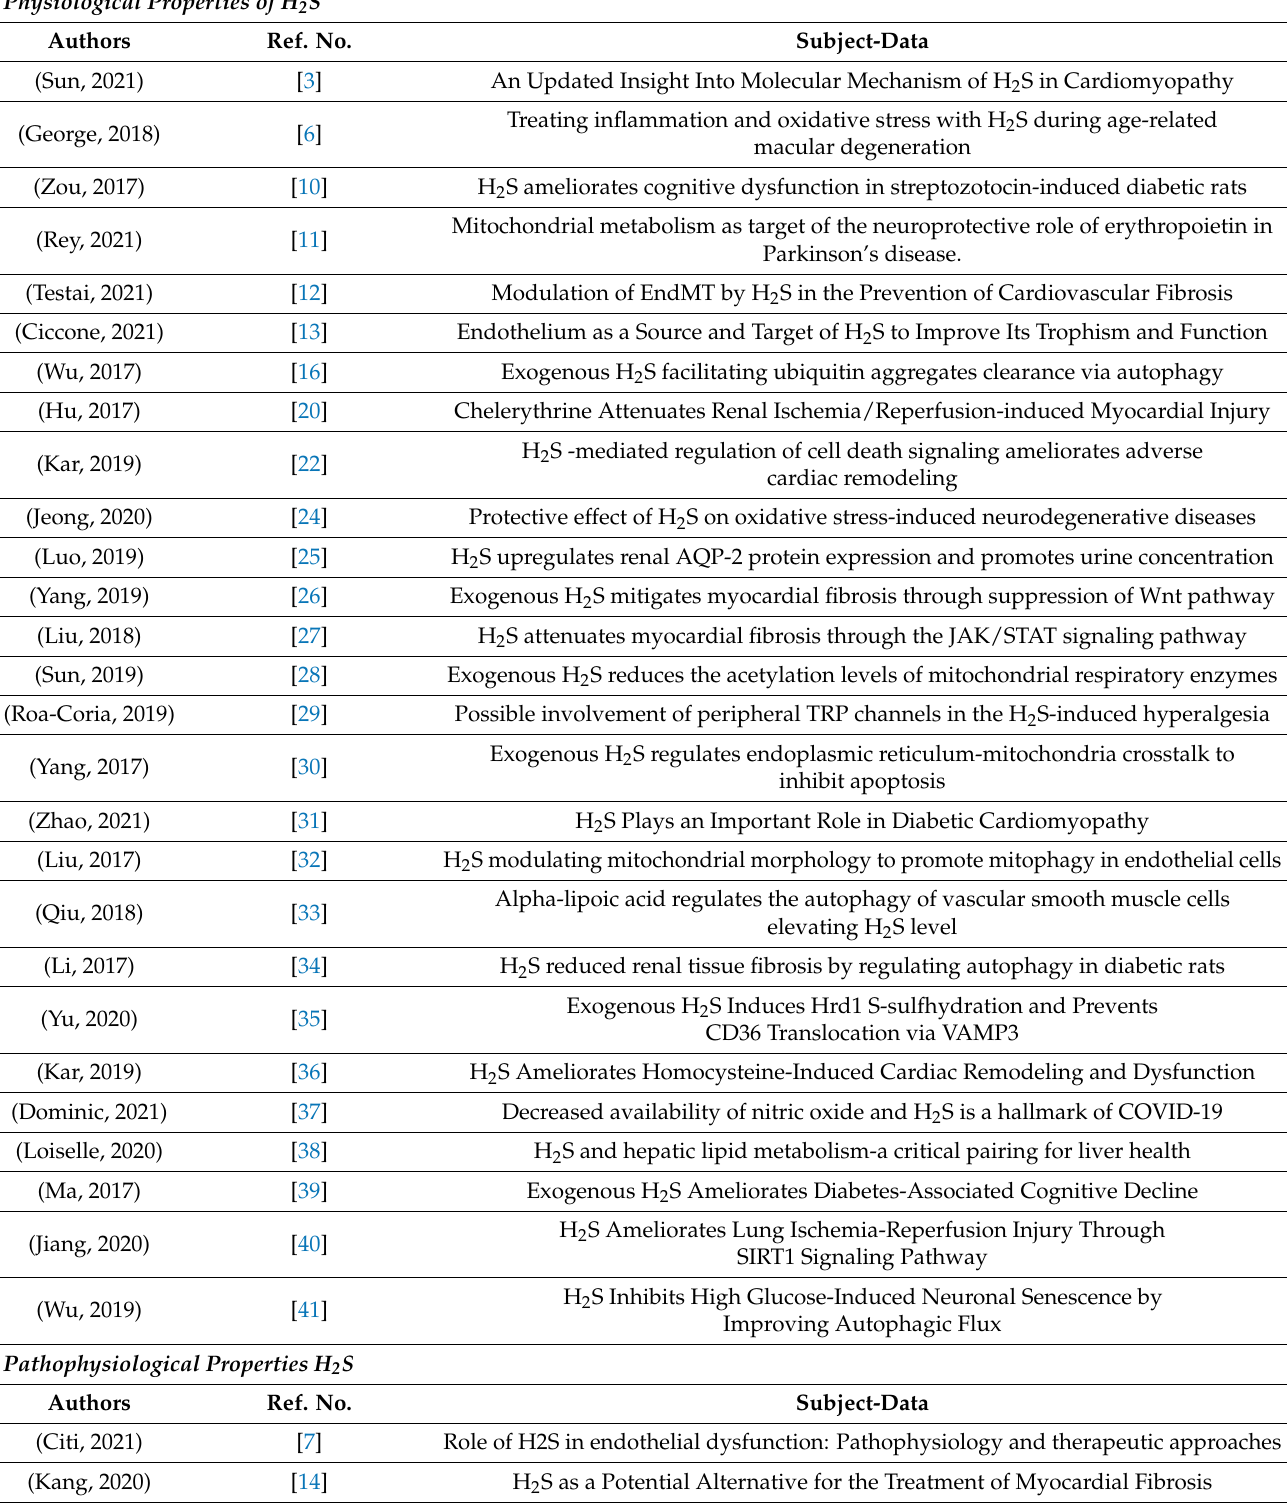
Table 2. PRISMA resulting conceptual skeleton structure of the article’s organization